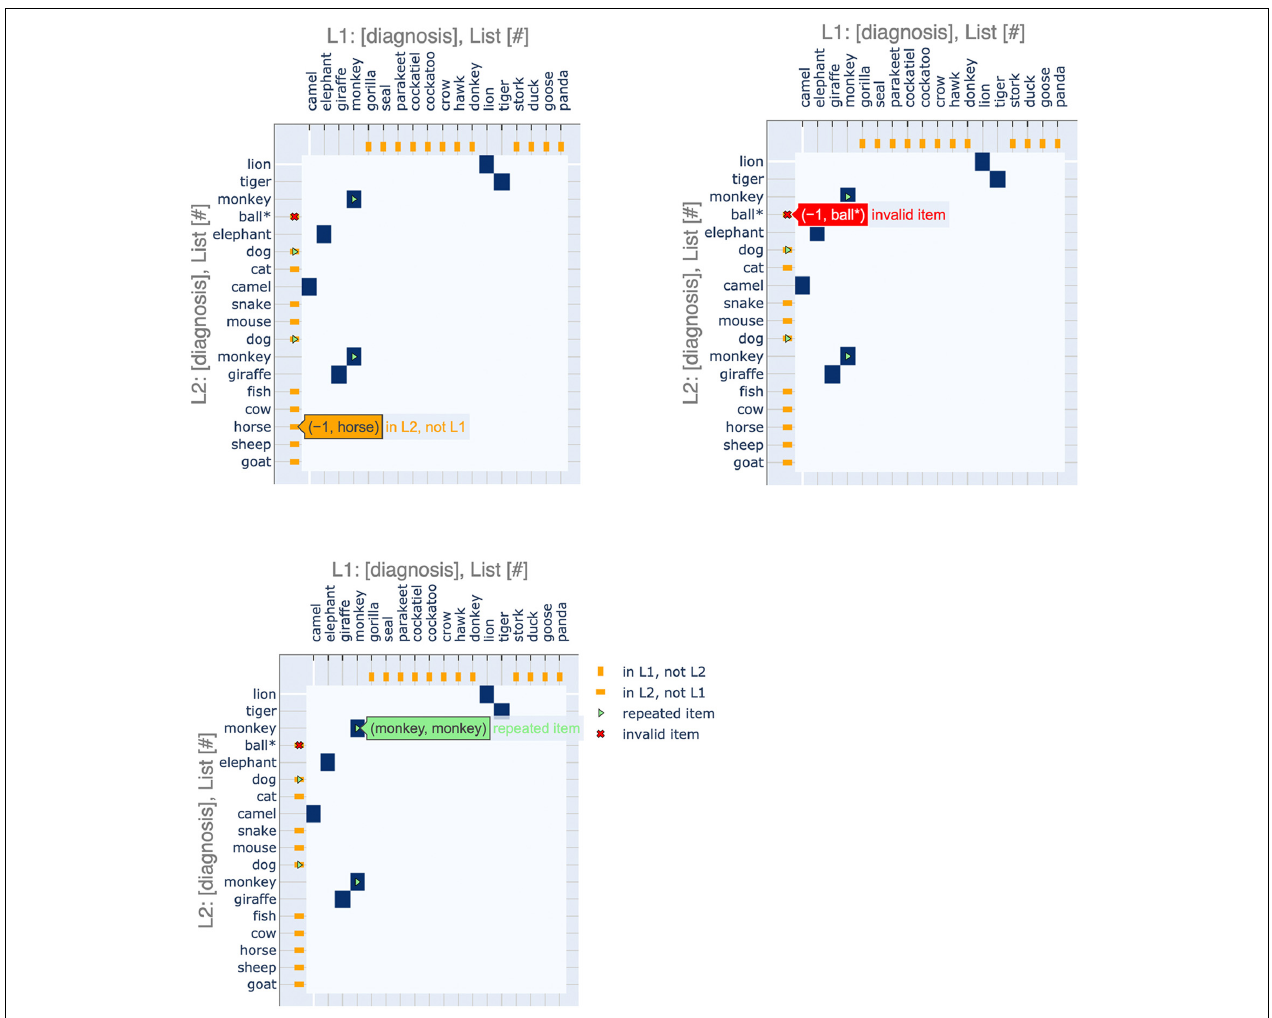
FIGURE 3 | Interactive features of visualizations. The plots can be made interactive to facilitate usage. Hovering over a point shows the identity of the items that it corresponds to as well as salient features, such as repeated or invalid